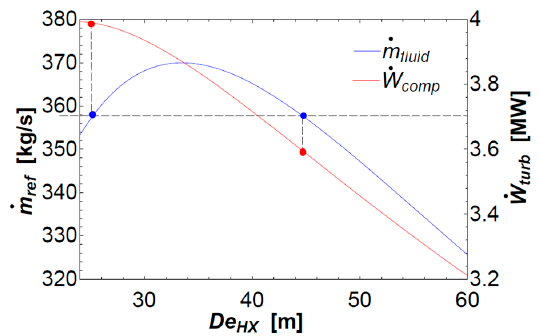
Figure 10. Refrigerant mass flow rate and work output change with condenser depth.